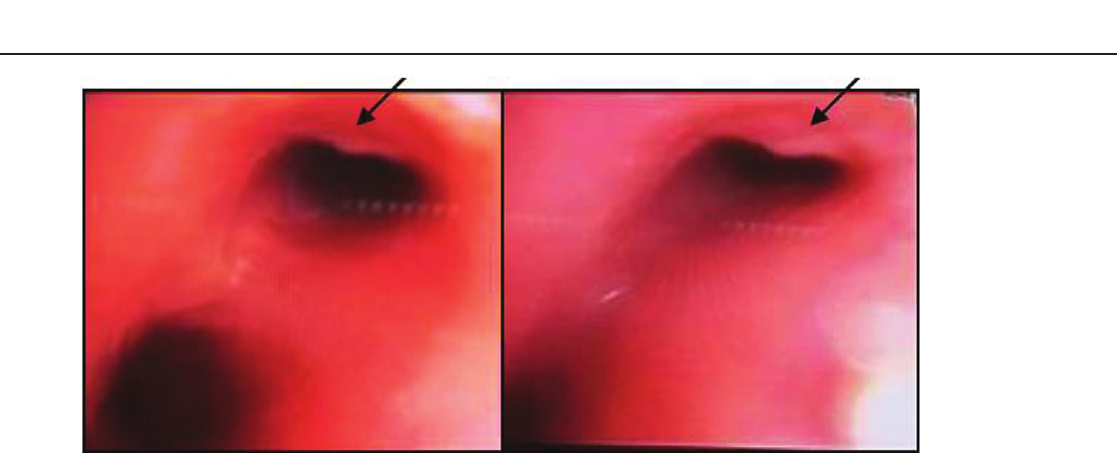
Airway stenosis due to remaining granulation tissue after removal of the foreign body (black